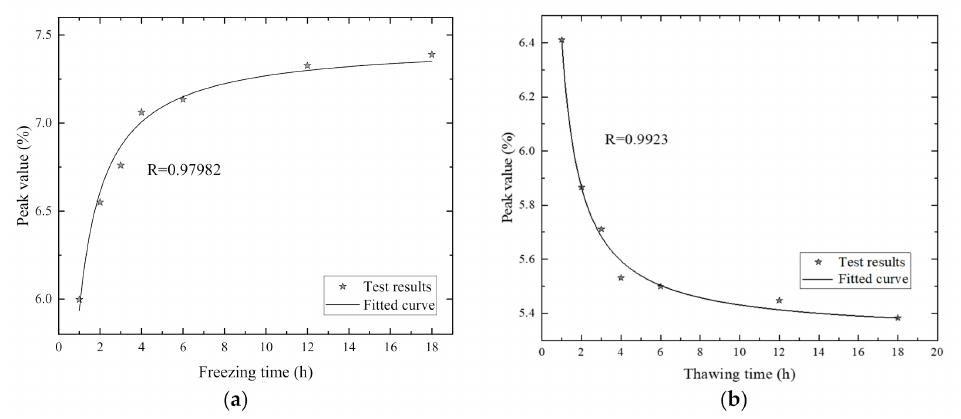
Figure 15. ( a , b ) Fitting curve of the peak value of freezing and thawing duration.